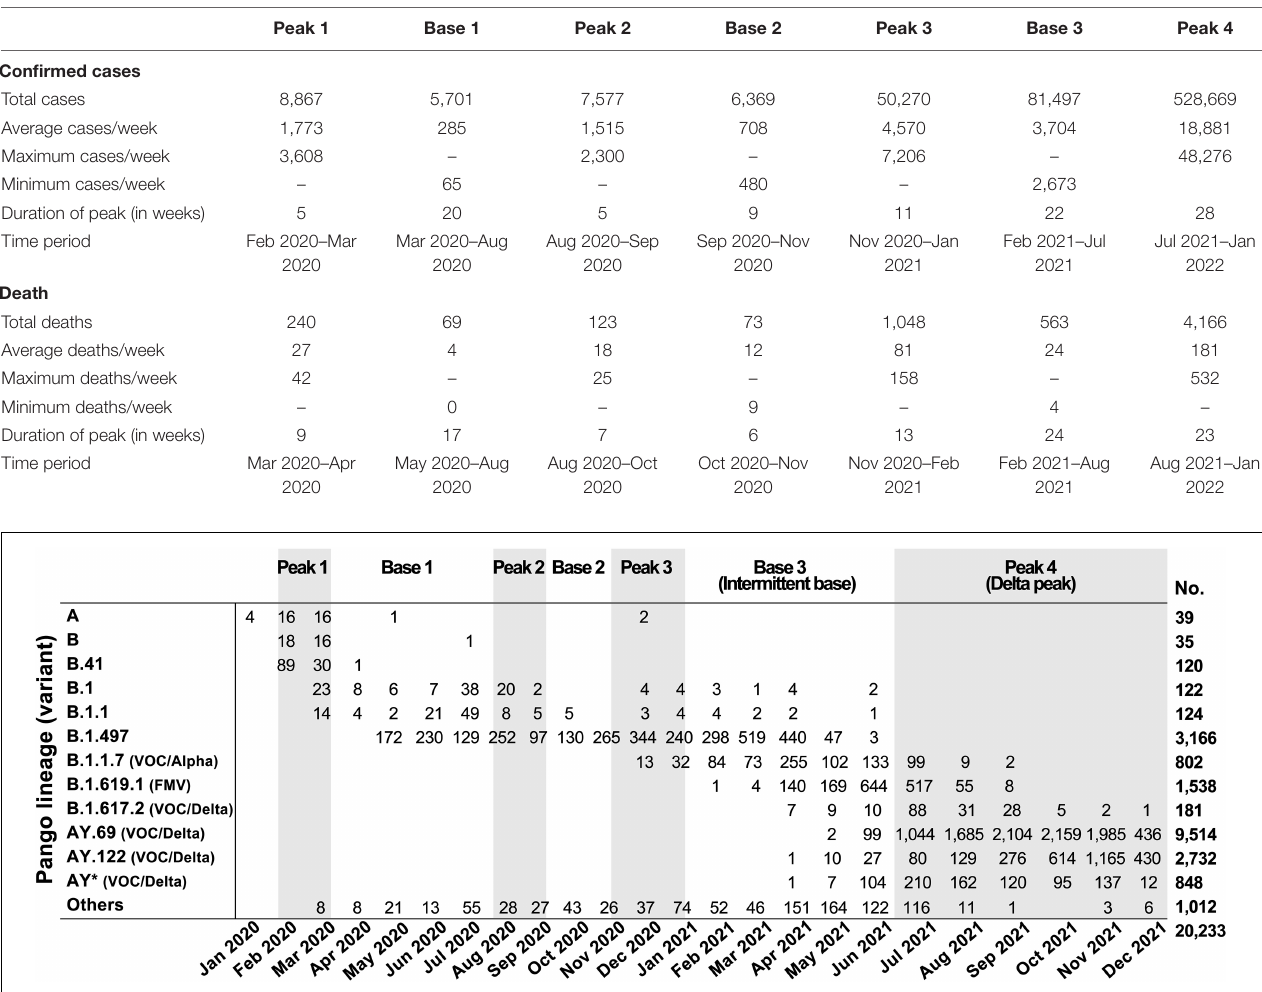
FIGURE 2 | SARS-CoV-2 variants identified in South Korea by month. Variants were classified based on Pango lineage v.3.1.17; WHO classifications are in parentheses. VOC, variant of concern; FMV, formerly monitored variant; AY*, AY lineages excluding AY.69 and